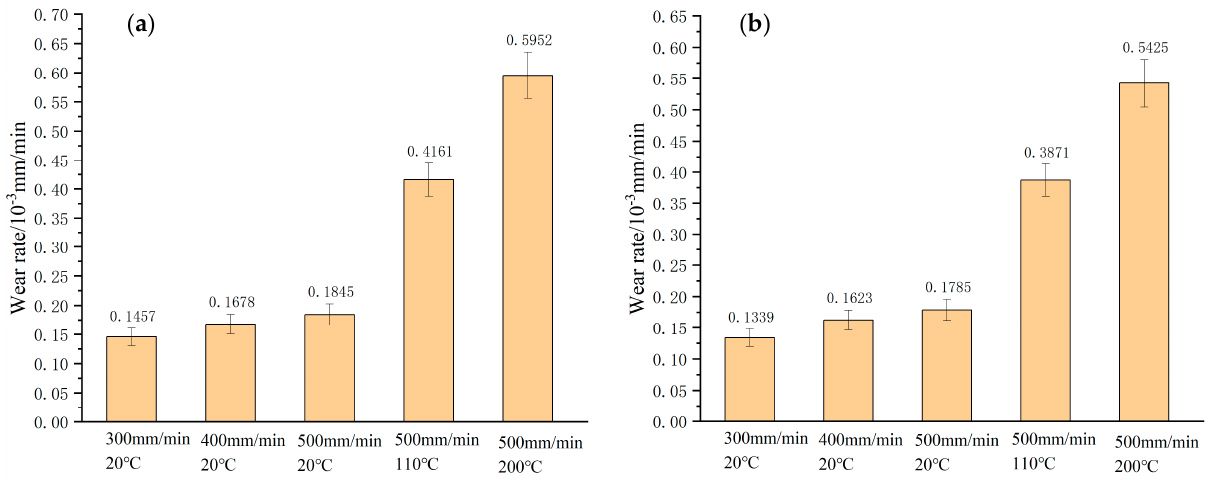
Figure 12. Wear rate under different conditions. ( a ) Wear rate of the hardened layer after laser hardening with a scanning speed of 700 mm/min. ( b ) Wear rate of the hardened layer after laser hardening with a scanning speed of 800 mm/min.